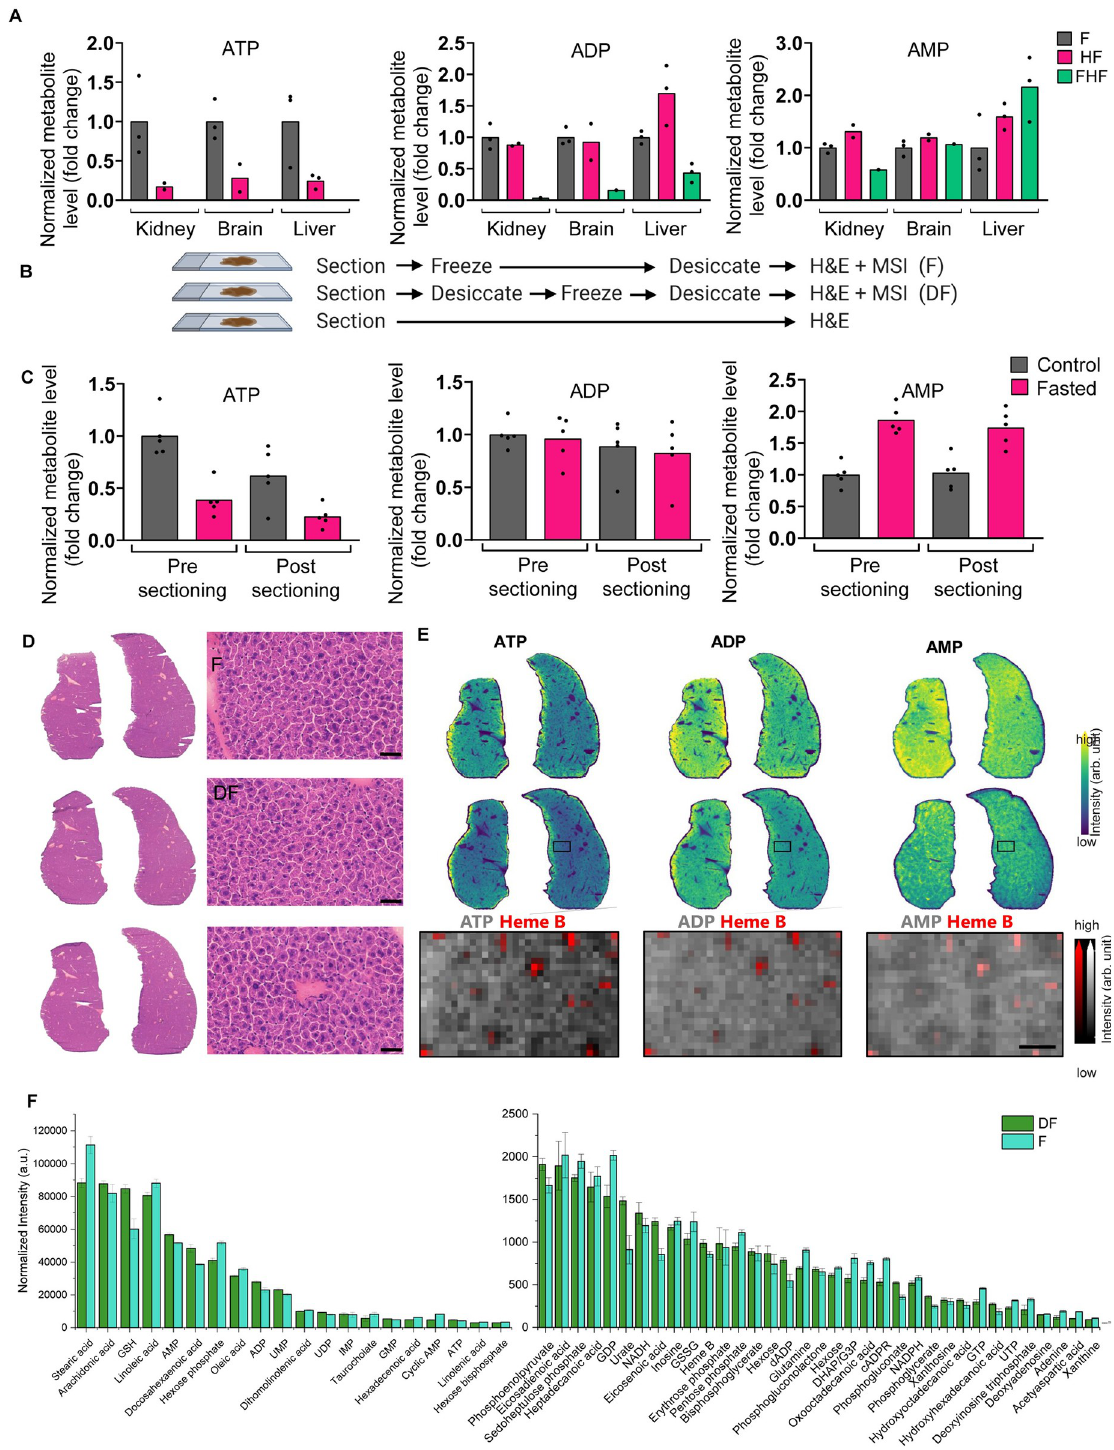
Fig 1. Evaluation of MALDI MSI sample preparation for small metabolites analysis. (A) Using a commercial heat stabilizing device, kidney, brain and liver tissues were subjected to freezing (treatment F ), heat treatment followed by freezing (treatment HF , top) or treatment FHF .LC-MS relative quantification of total ATP, ADP, and AMP levels in the three tissues underwent varied heat treatments. (B) Schematic overview of treatments where serial tissue sections were either frozen at -80˚C (treatment F ), desiccated before freezing (treatment DF ), or subjected to H&E staining directly after sectioning (H&E). (C) LC-MS relative quantification of total ATP, ADP, and